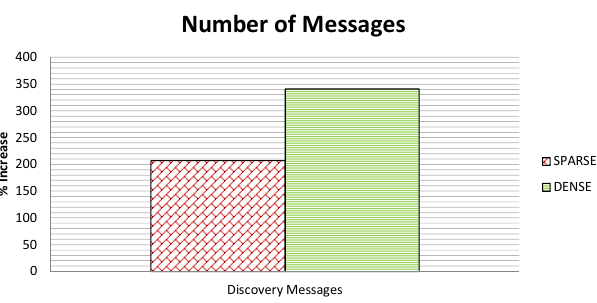
Figure 13. Discovery Messages in Sparse and Dense Scenarios.